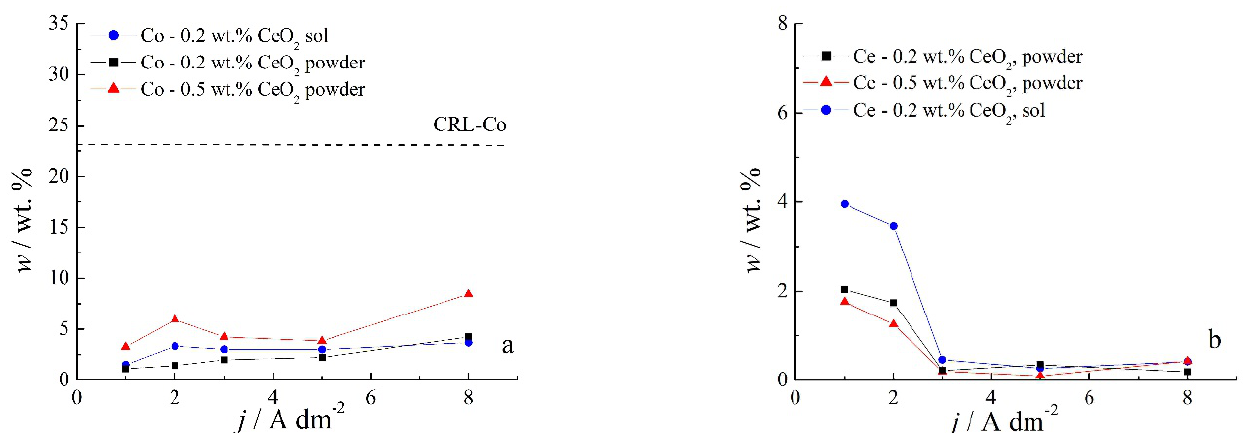
Figure 9. Dependence of the ( a ) Co and ( b ) Ce contents in Zn-Co-CeO 2 coatings on the deposition current density for coatings deposited under ultrasound from the solutions with different sources and amounts of CeO 2 particles.